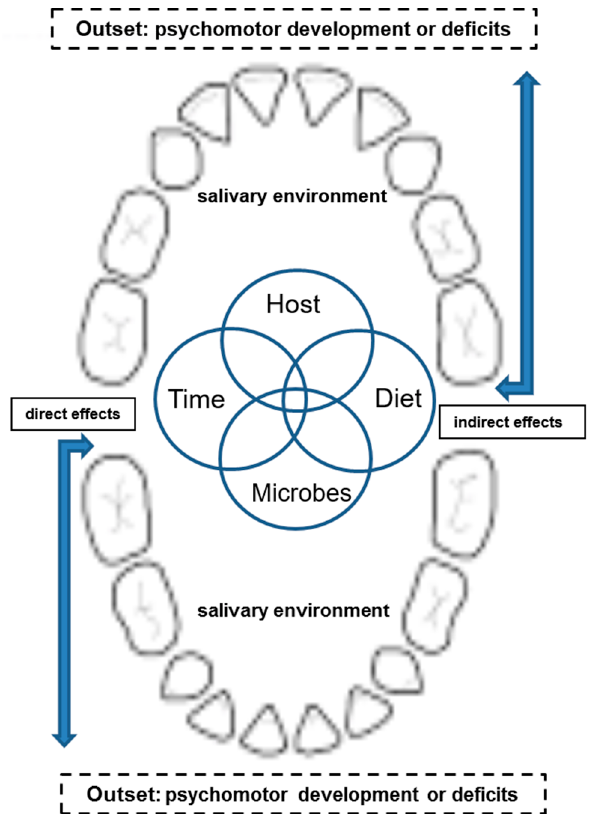
Figure 1. A new hypothesis is proposed, with edited modifications of the Classical Kele’s four circles during the initiation or progression of dental caries. Figure legend: A new hypothesis is proposed,